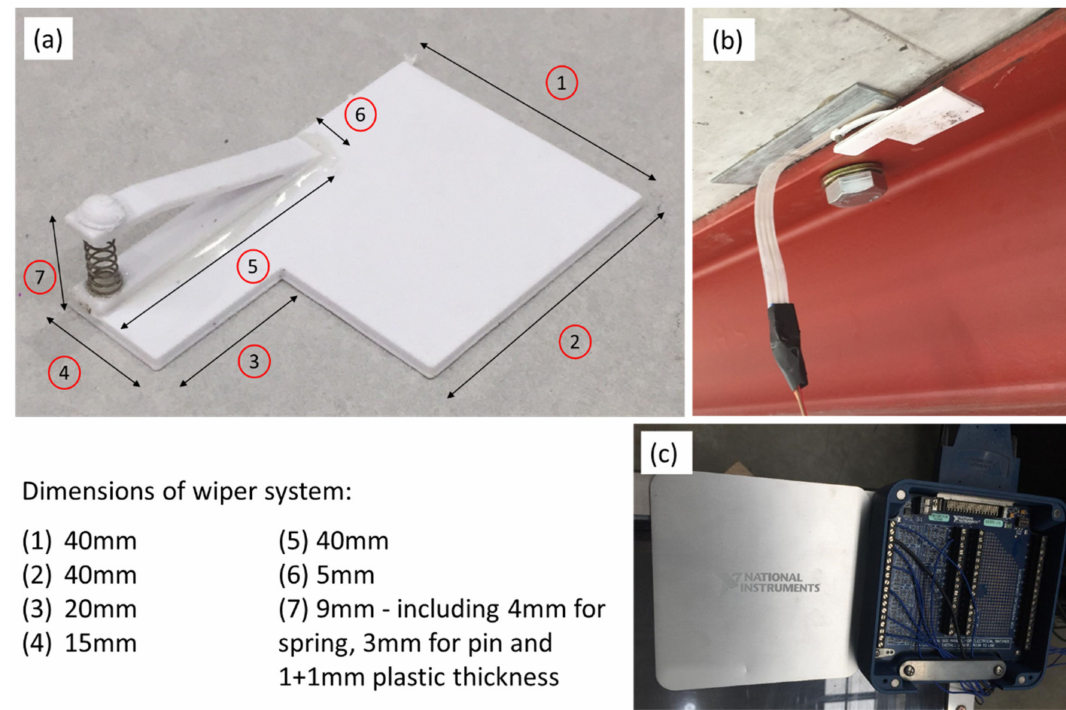
Figure 2. ( a ) 3D printed wiper, ( b ) the sensor installation on the SCC beam and ( c ) the sensors connected to the National Instruments data acquisition